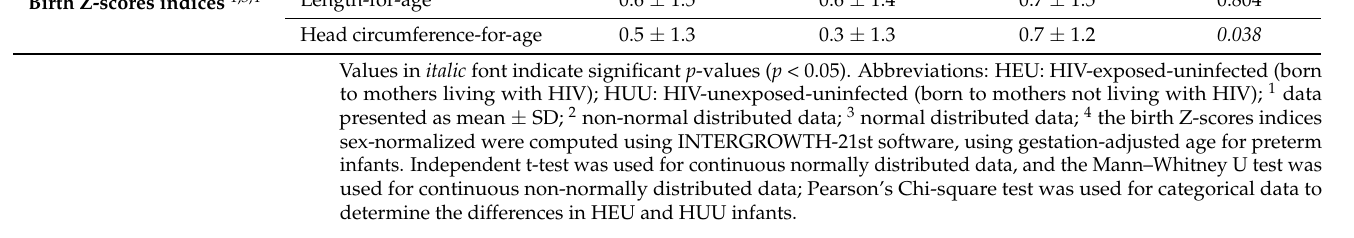
Table 3. Feeding practices of HEU and HUU infants before 6 months based on maternal